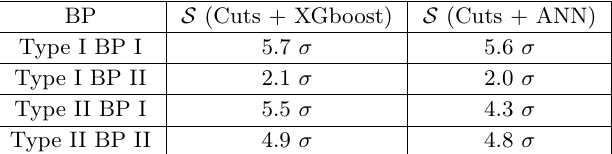
1 in the gluon = 3000 fb − L